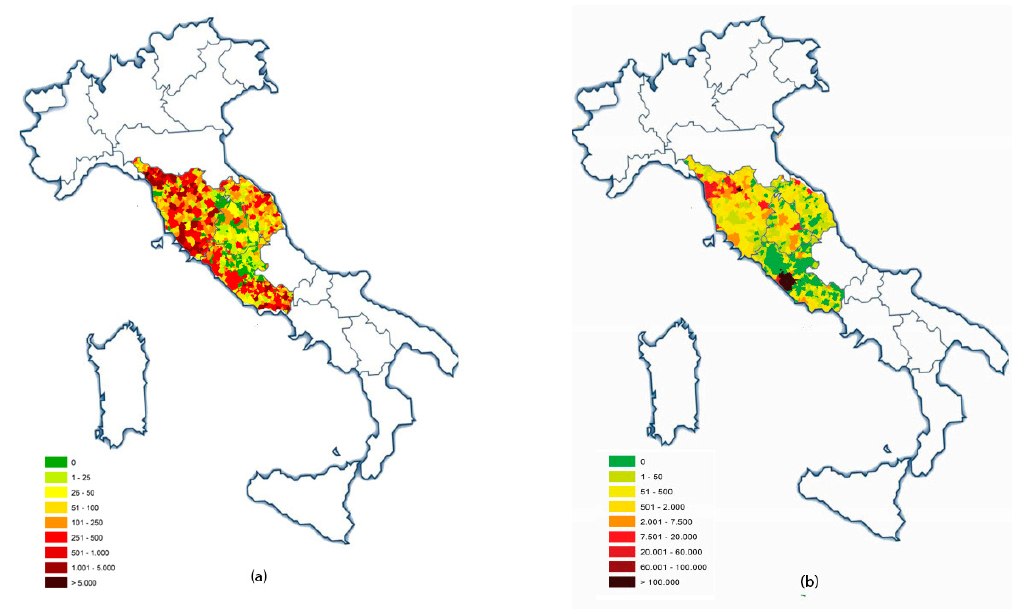
Figure 3. ( a ) The population at risk of landslides in Central Italy; ( b ) The population at risk of floods in Central Italy, derived from [60].